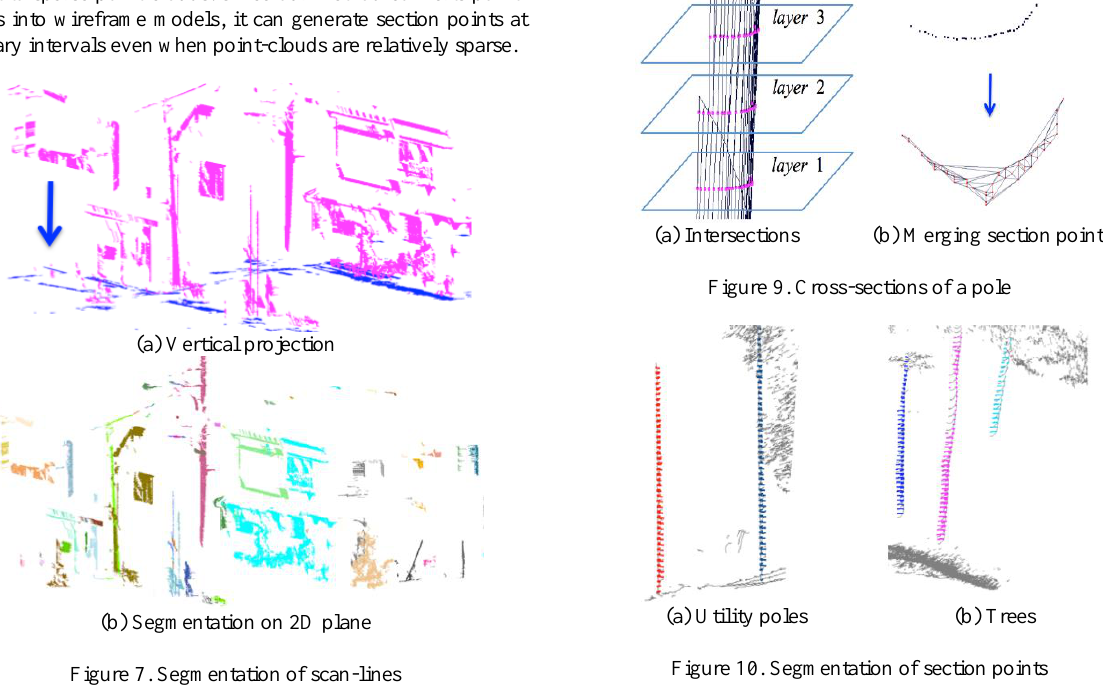
Figure 7. Segmentation of scan-lines